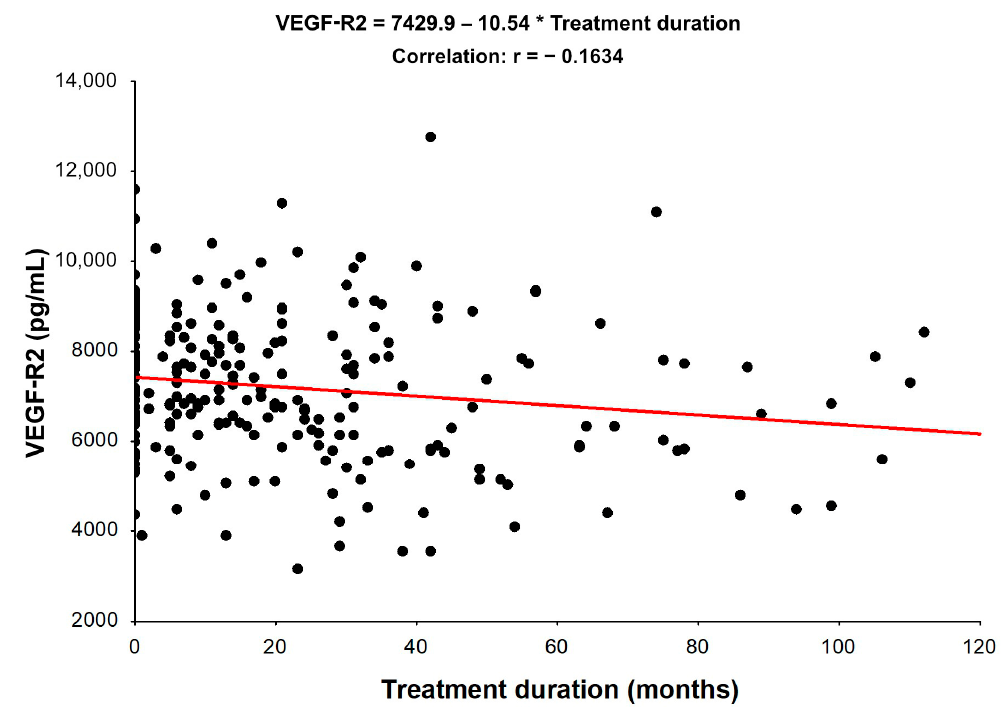
Figure 2. Spearman’s Rank Correlations. Spearman’s coefficients of the relationships among analyzed variables in NET patients: VEGF-R2 vs. Treatment duration (the presented correlation is statistically significant, p < 0.05).